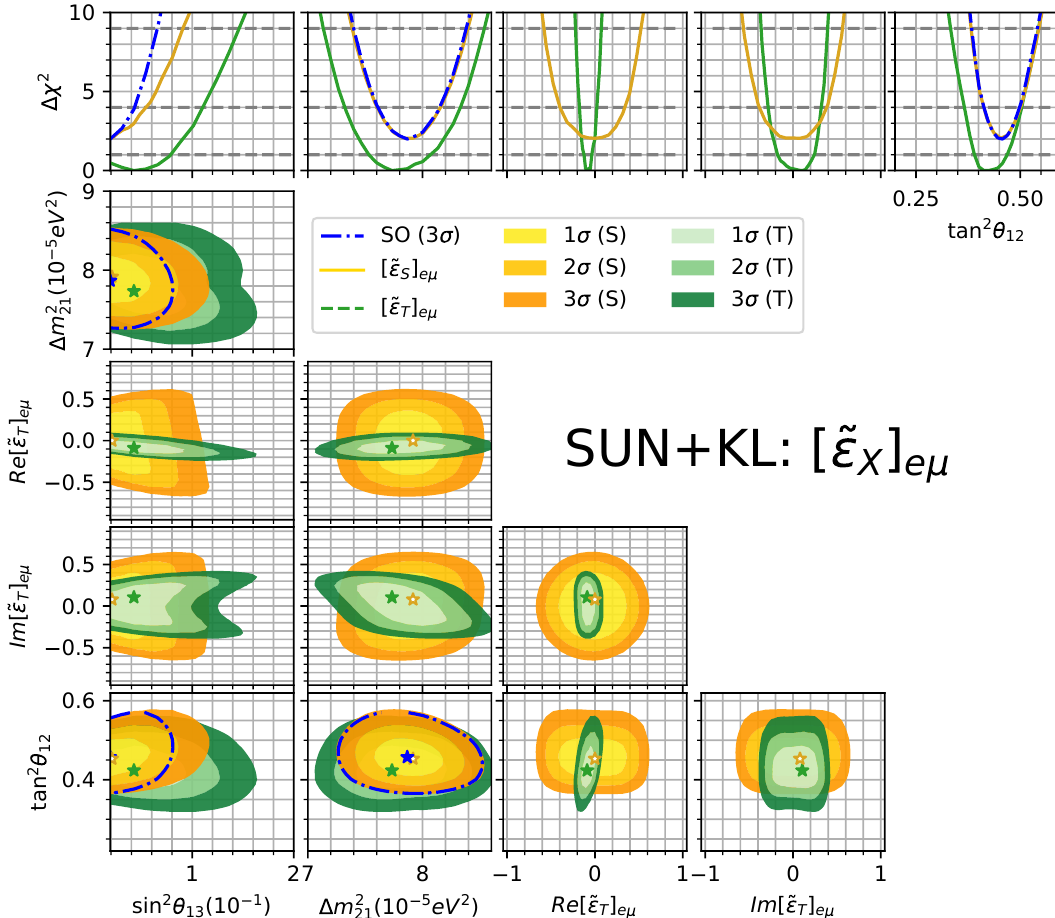
Figure 6 . The ∆ χ 2 of KamLand combined with solar experiments in the presence of [˜ (cid:15) X ] eτ , the contour levels at 1 σ , 2 σ and 3 σ and the 1D χ 2 curves. In green (yellow) curve is the NSI tensor (scalar) case and in dash-dotted blue curve is χ 2 ) . − min ( χ 2 SO NSI imaginary part of the [˜ (cid:15) ] that cause a non-zero CP violation effect, eq. (2.25), eµ X